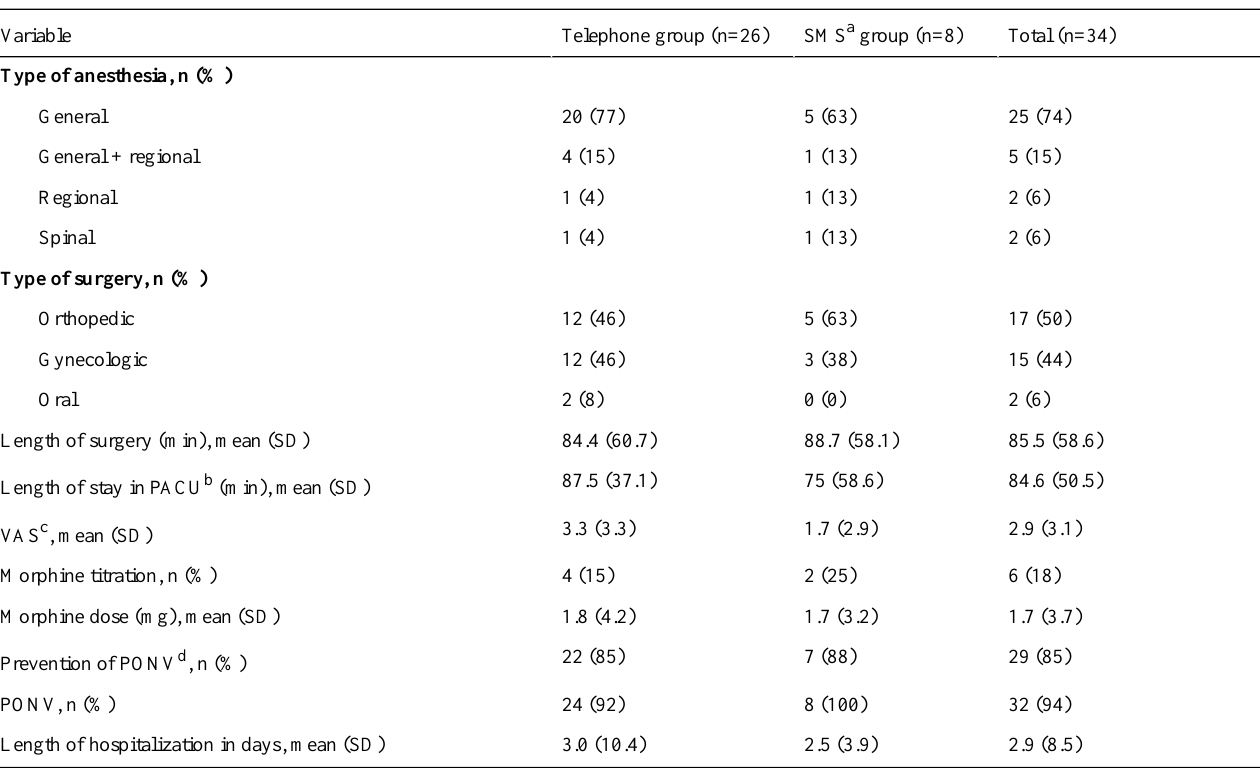
Table 3. Characteristics of patients converted to full-time